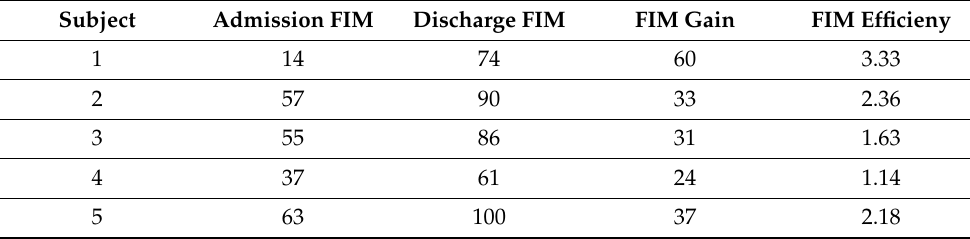
Table 4. Functional independence scores, FIM gain, FIM